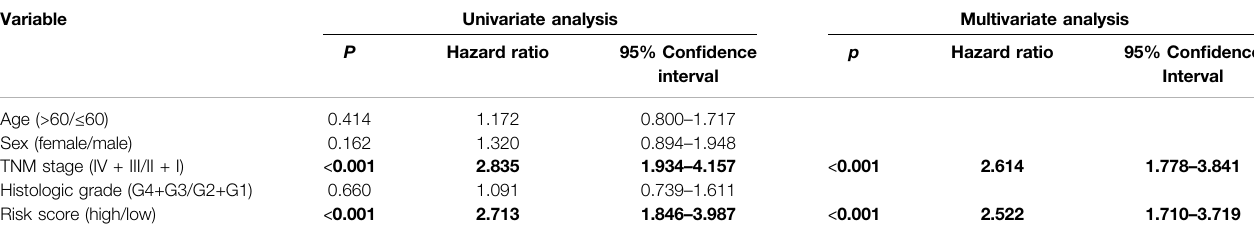
TABLE 4 | Univariate and multivariate regression analyses of OS in HCC patients of the TCGA dataset. Variable